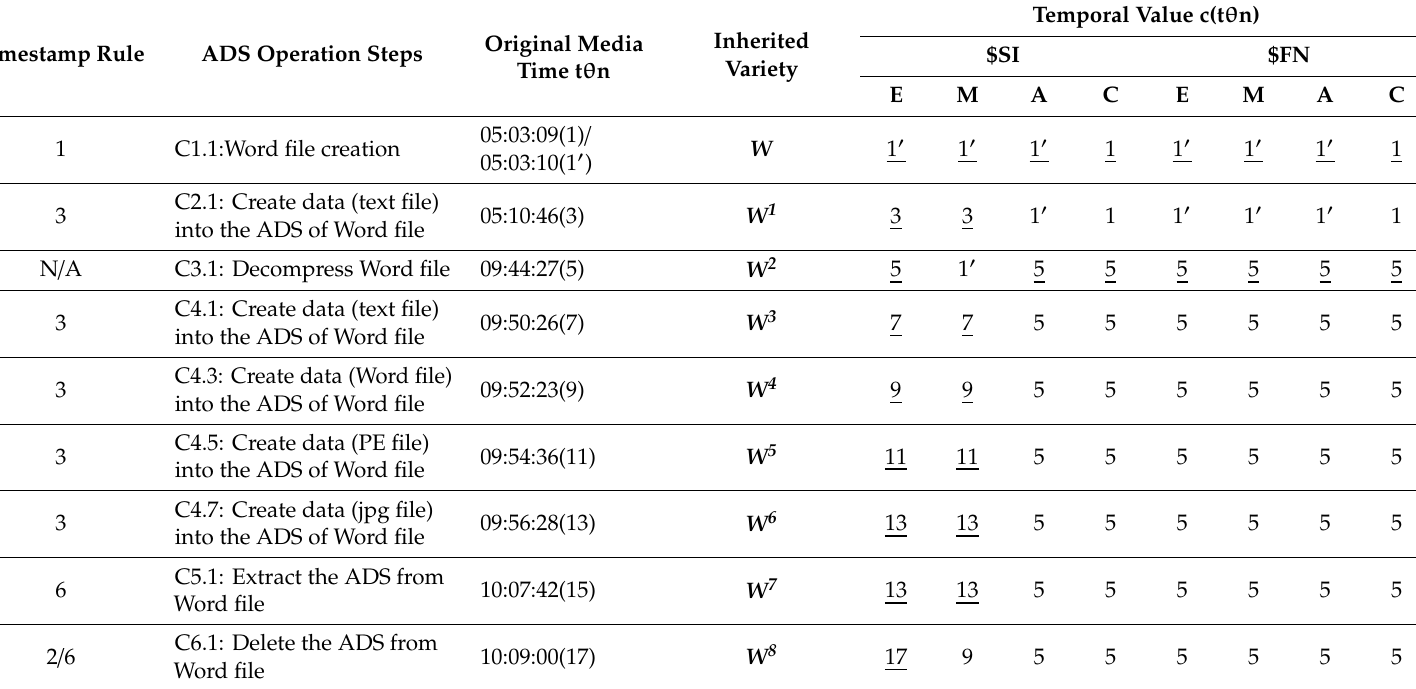
Table 12. Timestamp observation on Word ADS